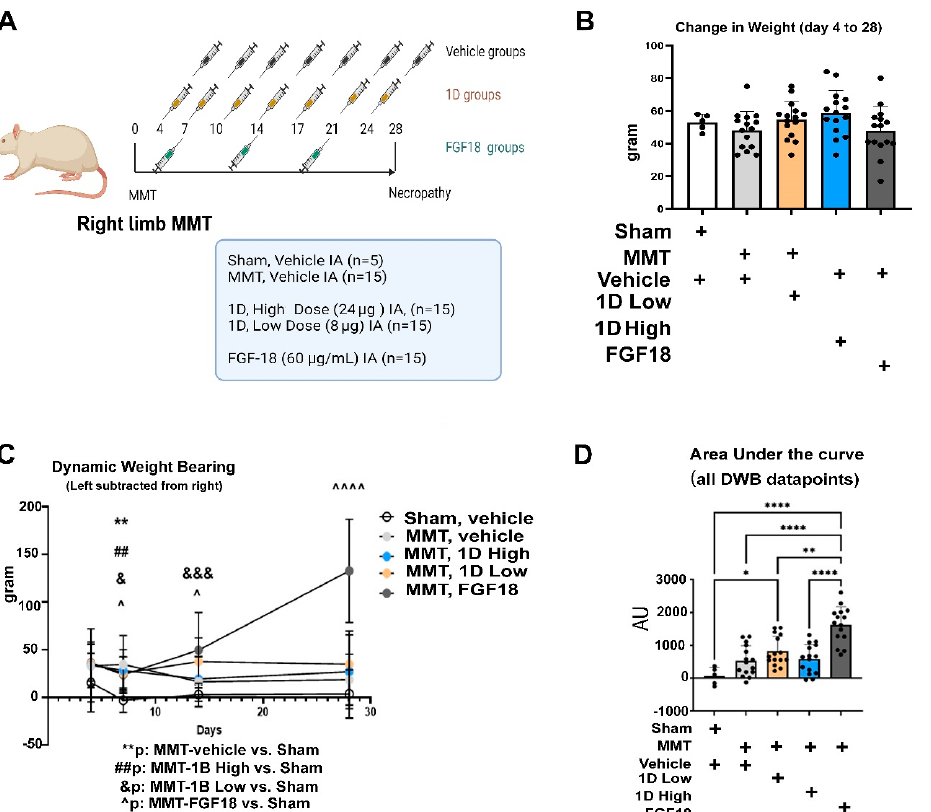
Figure 3. MMT experimental setup and behavioral phenotyping: ( A ) Experimental setup of MMT procedure carried out in the right hind limb of Lewis rats. Five groups were examined (Sham, n = 5; MMT-Vehicle n = 15; MMT-1D, low dose 8 µg n = 15; MMT-1D, high dose 24 µg n = 15; and MMT-